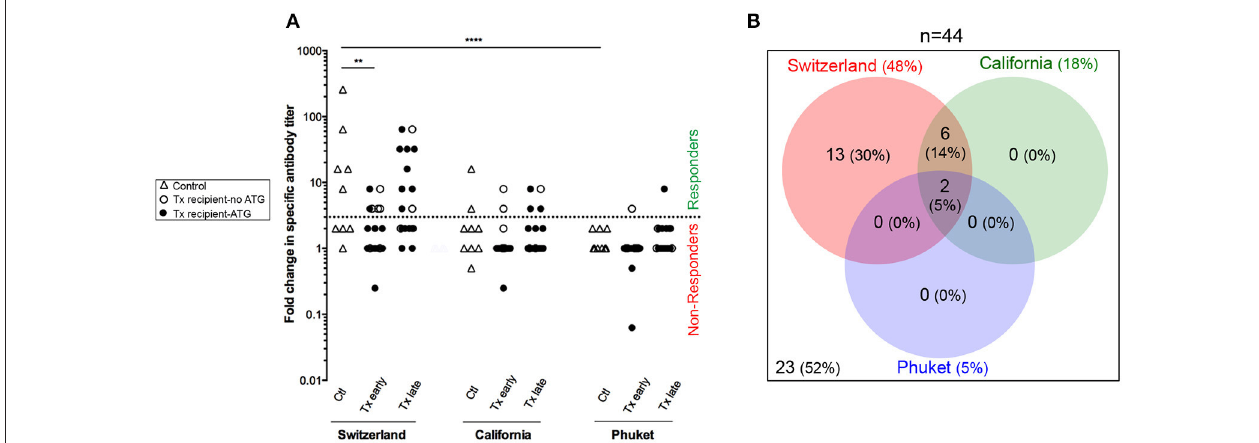
FIGURE 5 | Antibody response to flu vaccination. (A) Hemagglutination-Inhibition assay was used to measure the titer of antibodies specific of each strains of influenza virus (Switzerland, California, and Phuket) present in the vaccine. The titer was measured just before and 21–28 days post-vaccination and results are expressed as a ratio of these two values for healthy volunteers ( n = 9; controls, Ctl; open triangles), and transplant patients ( n = 36, circles). The nature of induction immunosuppressive therapy received by transplant patient is indicated. Transplant patients were distributed into two groups according to the time elapsed since transplantation: (i) 6–12 months: early post-transplantation (Early Tx; n = 18), and (ii) > 12–72 months: late post-transplantation (Late Tx; n = 18). Dotted line indicates the threshold of fold change in specific antibody titer above which the patient was considered as responder ( ≥ 4). (B) The Venn diagram summarizes the relations between the responses to the various virus